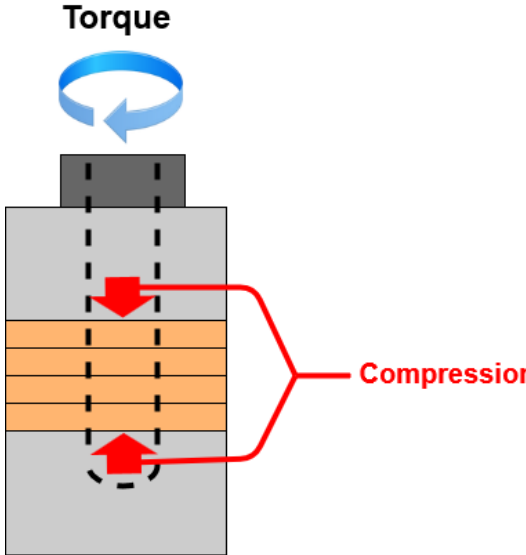
Figure 8. Compression forces according to the torque fluctuation.